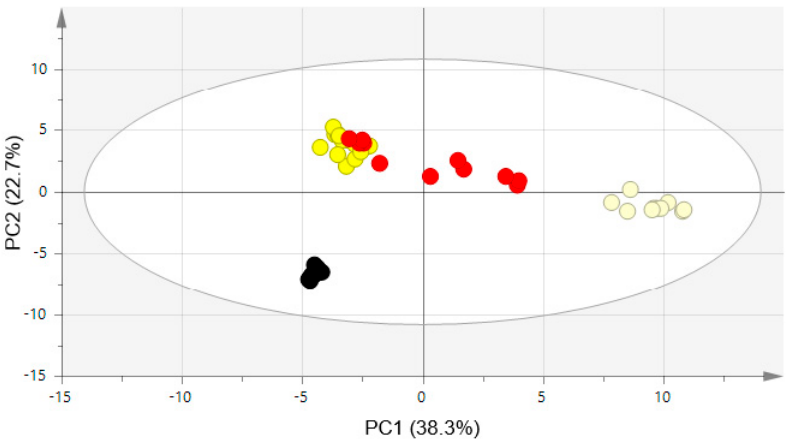
Figure 4. PCA score plot of four processed ginseng products. R 2 values for PC1 and PC2 are 0.383 and 0.227, respectively. The total number of components is 11. R 2 (cum) and Q 2 (cum) are 0.931 and 0.809, respectively. ● , white ginseng; ● , tae-geuk ginseng; ● , red ginseng; ● , black ginseng.